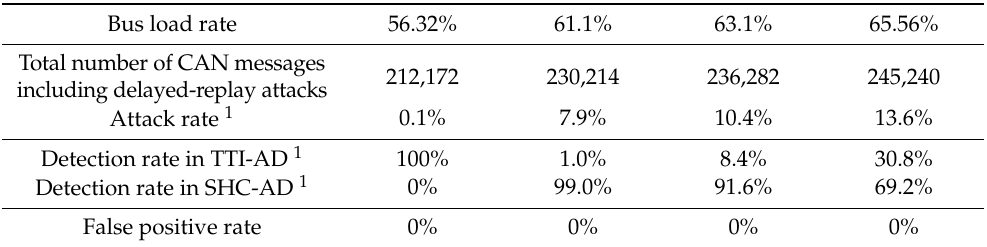
Table 7. Detection performance against delayed-replay attacks as a function of the bus load